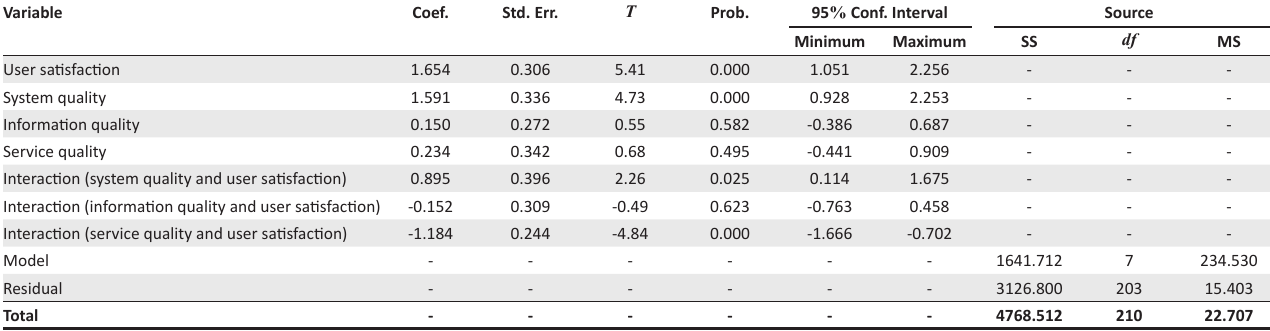
TABLE 5: Regression model for net benefits (with interaction terms).